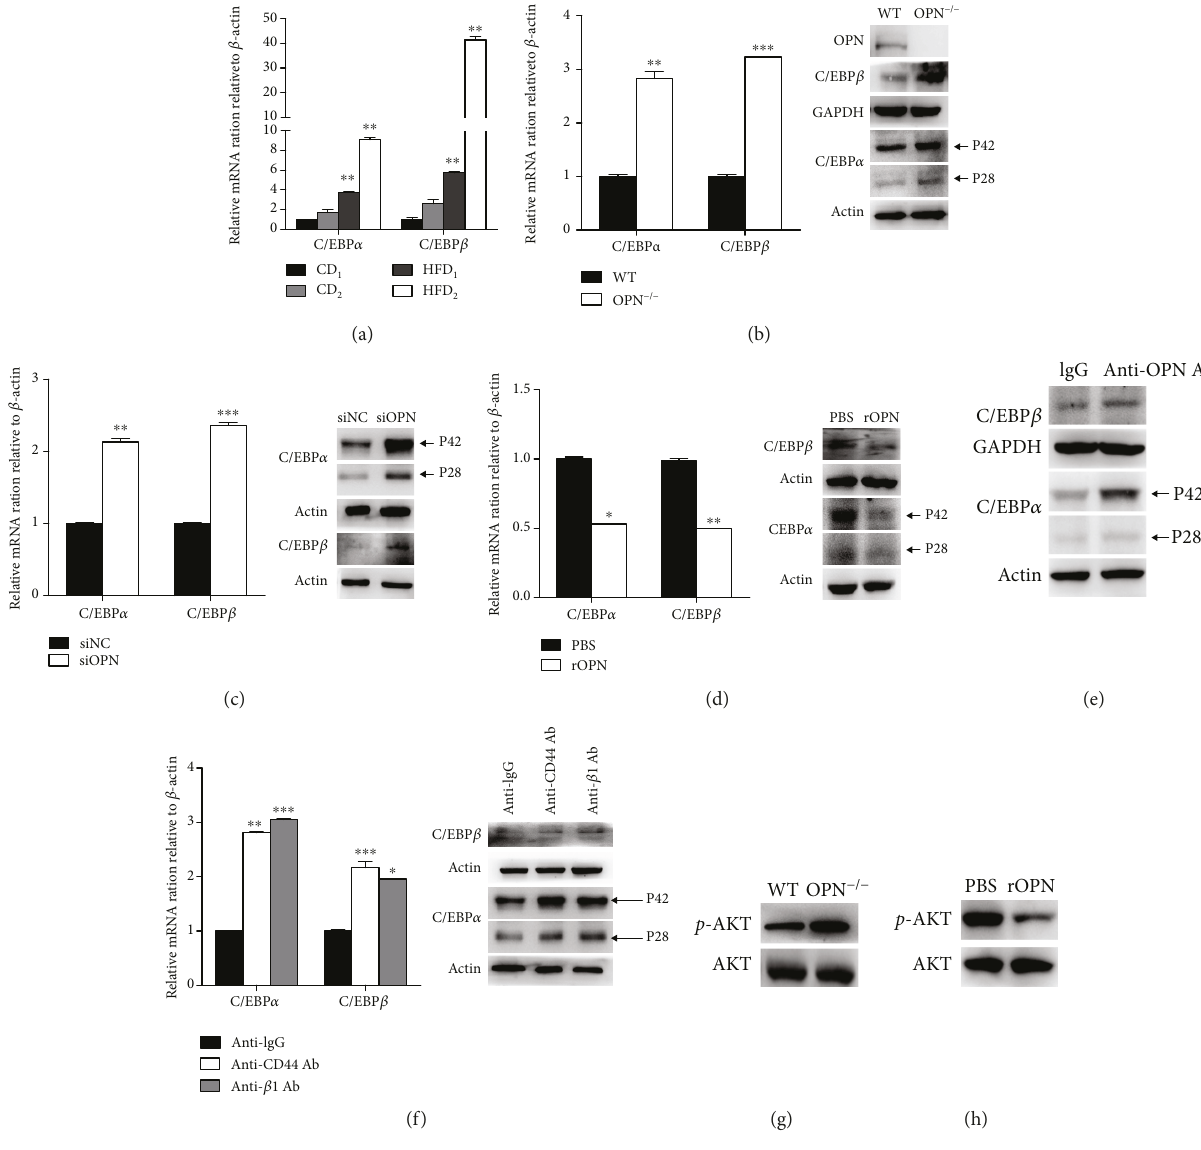
Figure 5: C/EBPs are involved in the OPN-directed adipogenic di ff erentiation of ASCs. (a) Total RNA from CD or HFD ASCs was assayed for C/EBP α and C/EBP β mRNA by real-time polymerase chain reaction (PCR). (b) Total RNA from WT or OPN − / − ASCs was assayed for C/EBP α and C/EBP β mRNA by real-time PCR. Total protein from OPN − / − or WT ASCs was analyzed for OPN, C/EBP α , C/EBP β (b), and p-AKT (g) by western blotting. (c) Total RNA and protein preps from the WT ASCs transfected with OPN siRNA (siOPN) or control siRNA (siNC) assayed for C/EBP α and C/EBP β 3 days after transfection. (d) Total RNA and protein preps from OPN − / − ASCs with rOPN (rOPN) or PBS were assayed for C/EBP α and C/EBP β by real-time PCR and western blot, and (h) protein preps from the same cells were assayed for p-AKT by western blot 2 days after addition. WT ASCs were supplemented with OPN-speci fi c antibody (anti-OPN Ab) (10 μ g/ml) for 2 days. Total protein preps from WT ASCs with anti-OPN Ab (anti-OPN Ab) and control cells (lgG) were assayed for C/EBP α and C/EBP β (e) by western blot. (f) Wild-type ASCs were supplemented with blocking antibodies against CD44 or integrin αν / β 1 or an isotype control (each 5 μ g/ml) for 2 days. Total RNA and protein preps from WT ASCs with CD44 (anti-CD44) or integrin αν / β 1 Ab (anti- β 1 Ab) and control cells (anti-lgG) were assayed for C/EBP α , C/EBP β by real-time PCR and western blot. Values are means ± SEM. ∗ P < 0 05 ; ∗∗ P < 0 01 ; ∗∗∗ P < 001 . All experiments were repeated at least